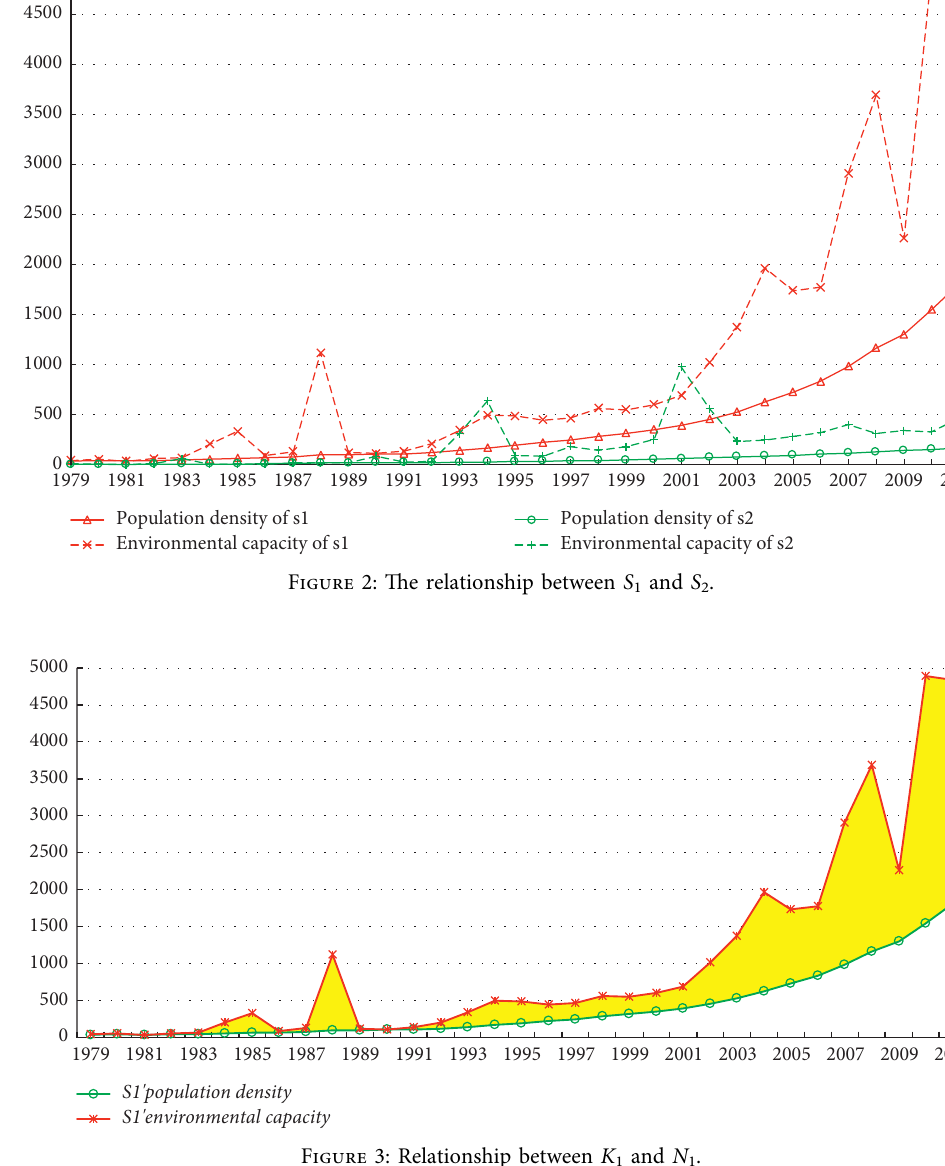
Figure 3: Relationship between K